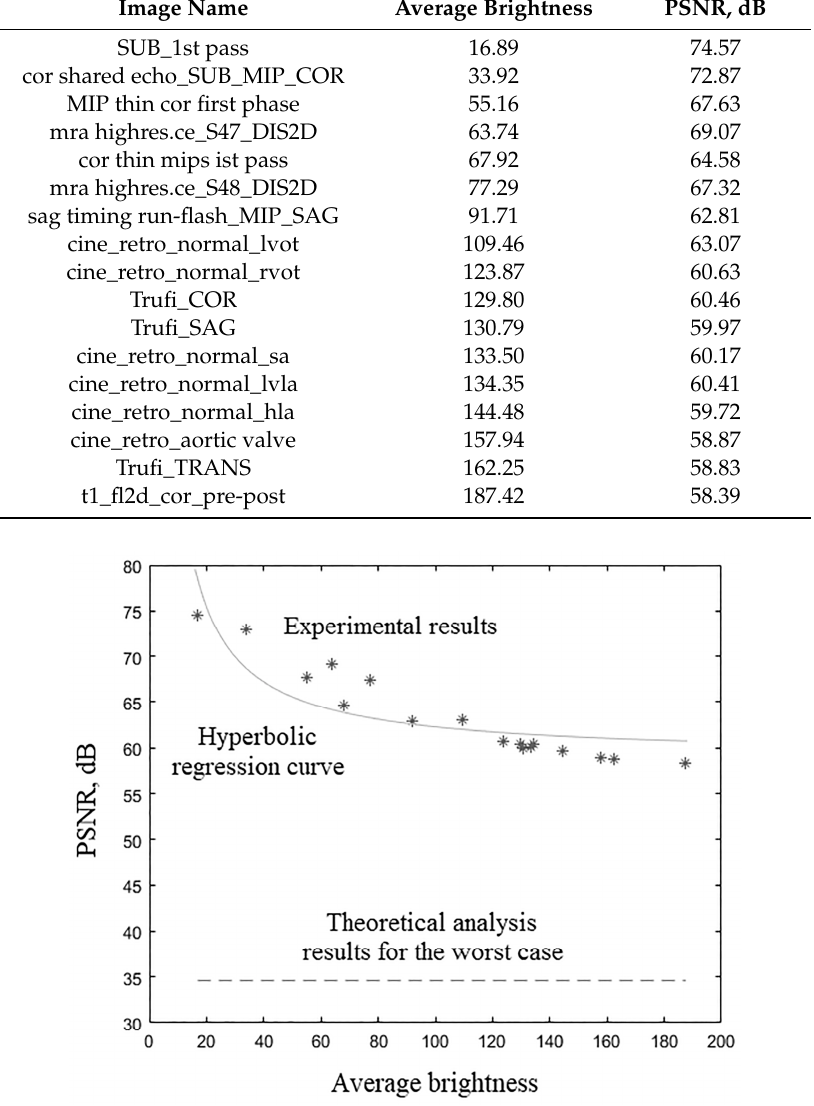
Figure 8. Experimental results of 3D tomographic 12-bit images DWT by wavelet db 4 with bit-width r = 11 of filters coefficients.